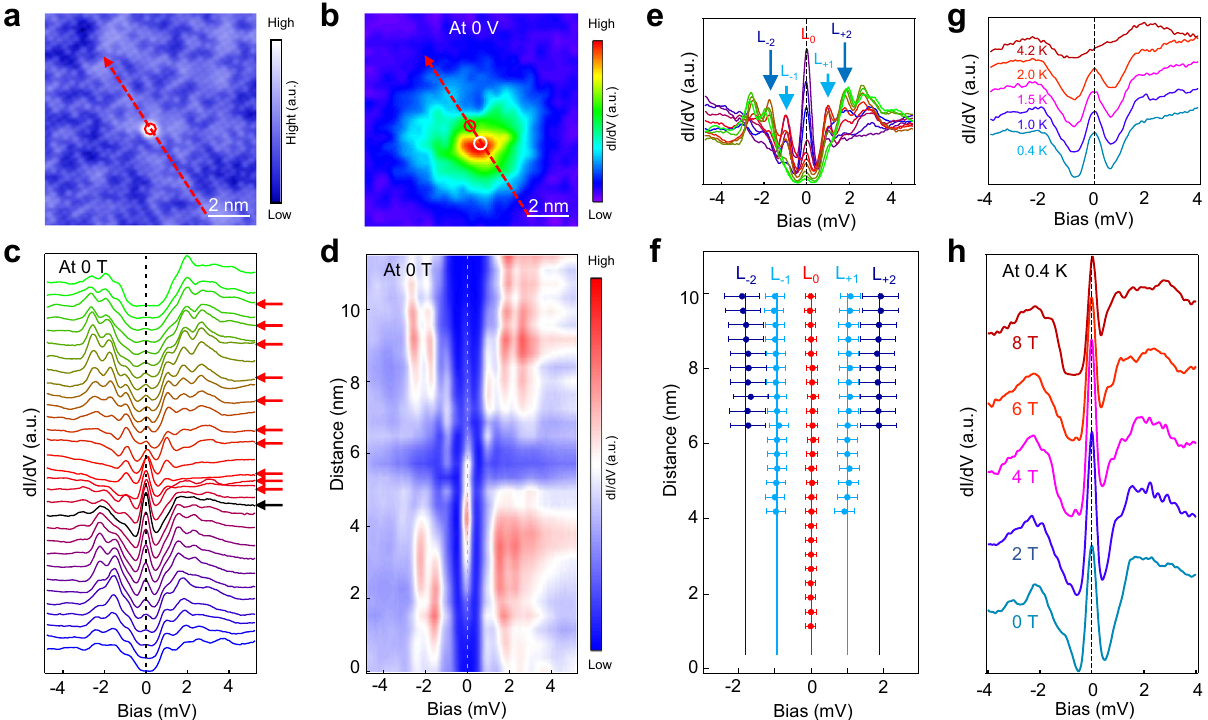
Fig. 2 ZBP and integer quantized in-gap states on type-I Fe adatoms. a An atomic-resolution topographic image ( V s = − 10 mV, I t = 100 pA) of a single type-I Fe adatom (red circle). b A zero-energy d I /d V map ( V s = − 10 mV, I t = 100 pA) of the same area in a . c and d d I /d V spectra and the corresponding intensity plot ( V s = − 10 mV, I t = 200 pA) along the line-cut indicated by the red dashed and arrowed line in a and b . The decay length of the ZBP is about 2.5 nm. e A stacking plot of several d I /d V spectra ( V s = − 10 mV, I t = 200 pA) marked by the red arrows in c . The energies of the in-gap states are labeled as L 0 , L ±1 , L ±2 . f The energies of the in-gap states at different spatial positions along the line-cut. Error bars are the FWHM of a Gaussian fi t. The energy values of the solid lines are calculated as the average energy of the in-gap states, showing the same integer quantization as the topological vortex core states anchored by the MZM. g Temperature dependence of the d I /d V spectra ( V s = − 10 mV, I t = 200 pA) measured at zero-energy intensity center (white circle in b ) with the corresponding spectrum (the black curve) pointed by the black arrow in c . The ZBP intensity decreases with increasing temperature and becomes indiscernible at 4.2 K. h Magnetic fi eld dependence of the d I /d V spectra ( V s = − 10 mV, I t = 200 pA) also acquired at the zero- energy intensity center (white circle in b ) at 0.4 K. The ZBP remains robustly at zero energy without